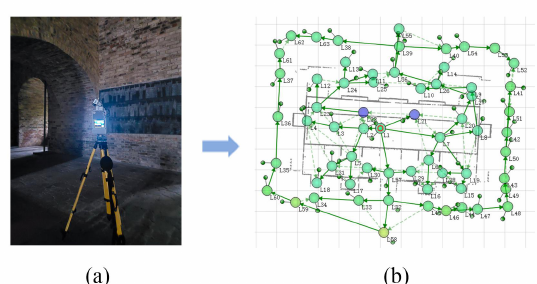
Figure 2. TLS-based survey for the Beamless Hall. (a) field survey with a Z+F Imager 5010X laser scanner. (b) spatial distribution of 63 scan-stations.